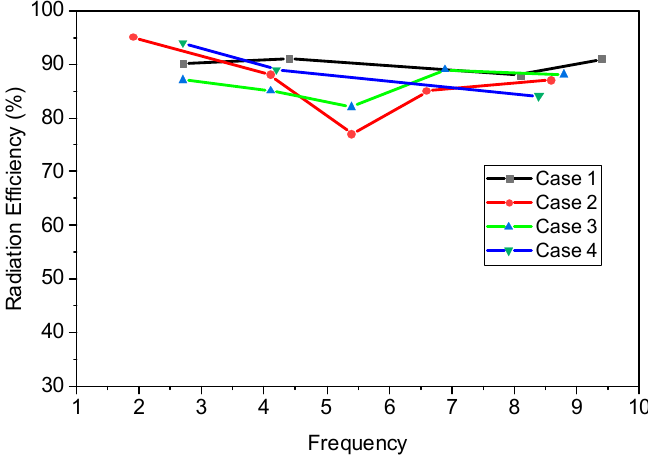
Table 8. Radiation Efficiency (%) in all four cases at resonance frequencies.